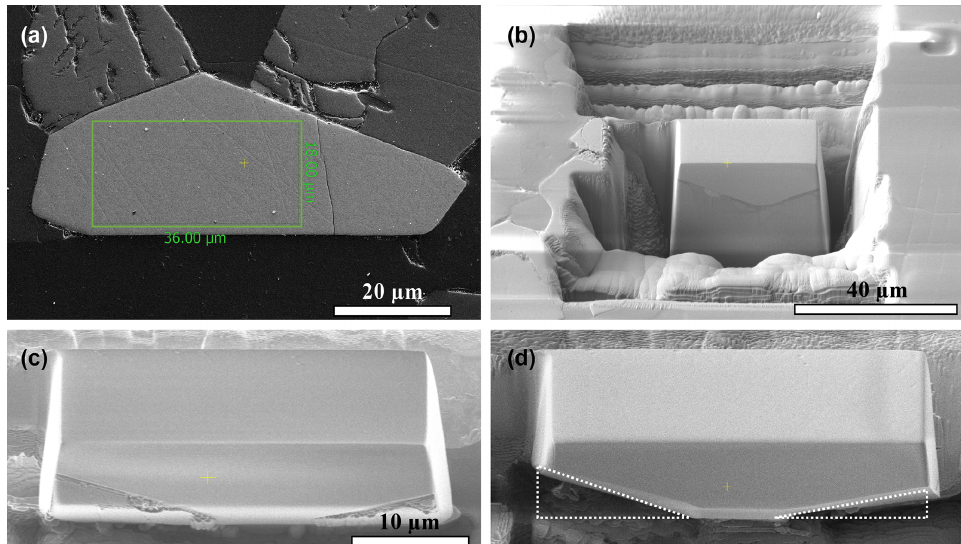
Figure 5. Xe + pFIB images detailing the extraction of a 36 × 18µm domain of a large (50µm) baddeleyite grain from a thin section of the Duluth gabbro (a) . During large-scale cutting (b) , small domains of common-Pb-bearing feldspar remained attached to the target baddeleyite (c) , though these were quickly removed using the Xe + pFIB instrument through a series of tilted and rotated cuts to produce a single grain with no rim or inclusions (d)